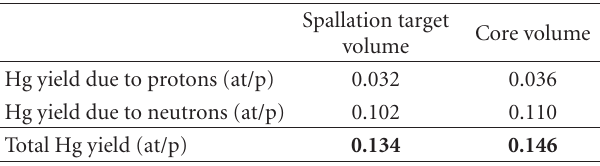
Table 4: Hg yield in atoms per source